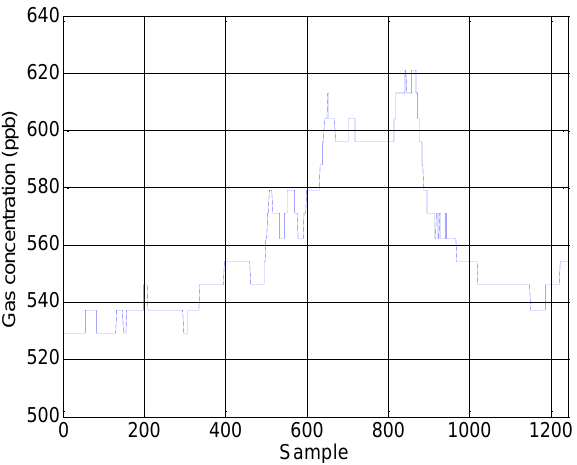
Figure 4. Raw gas concentration samples obtained during the exploration.